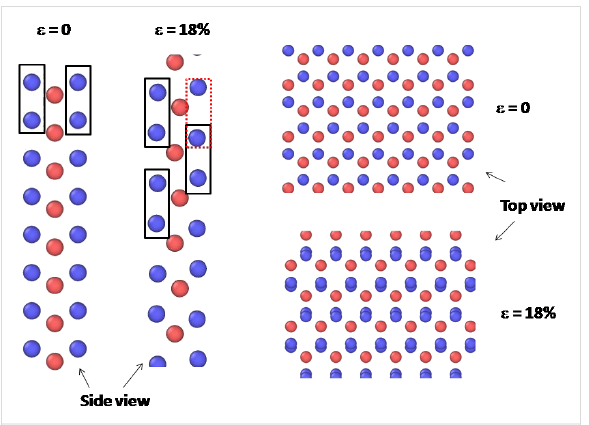
Figure 3: The top and side views of atomic structures under different uniaxial tension strains along the armchair direction of defect-free MoS 2